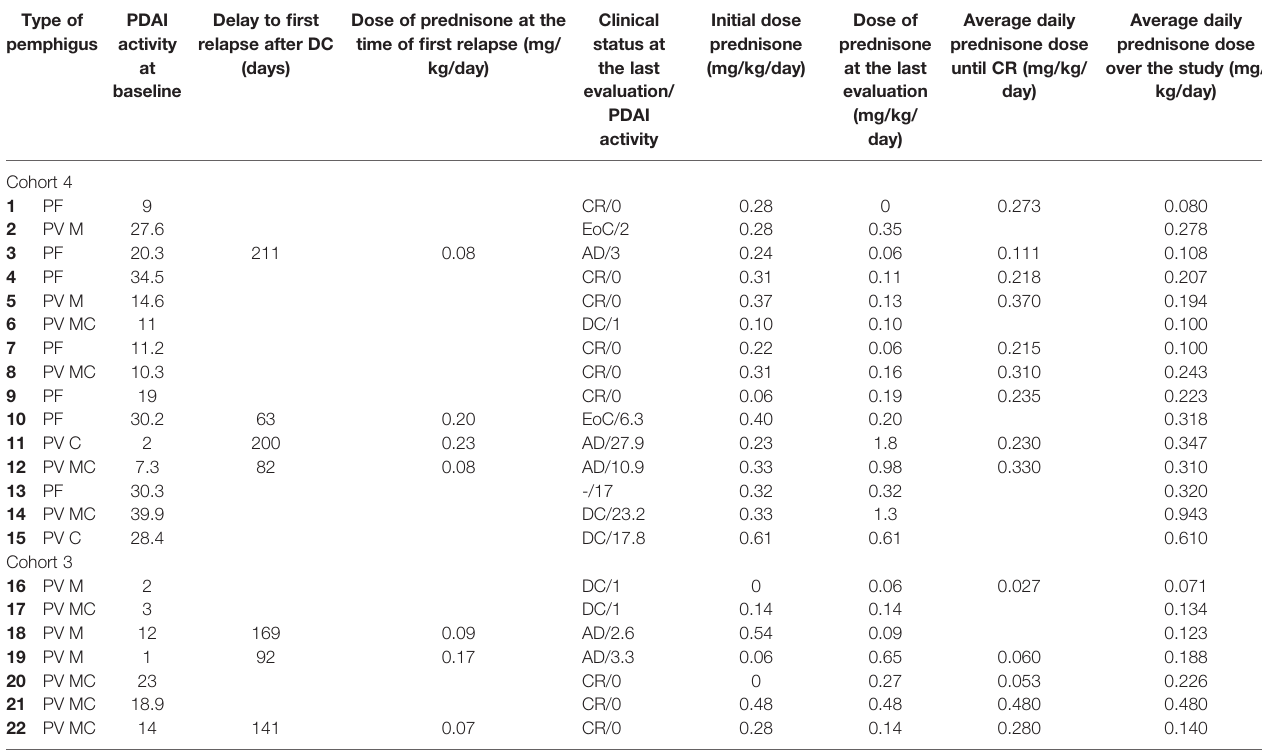
TABLE 2 | Clinical status and concomitant prednisone dose levels over time in cohorts 3 and 4. Type of